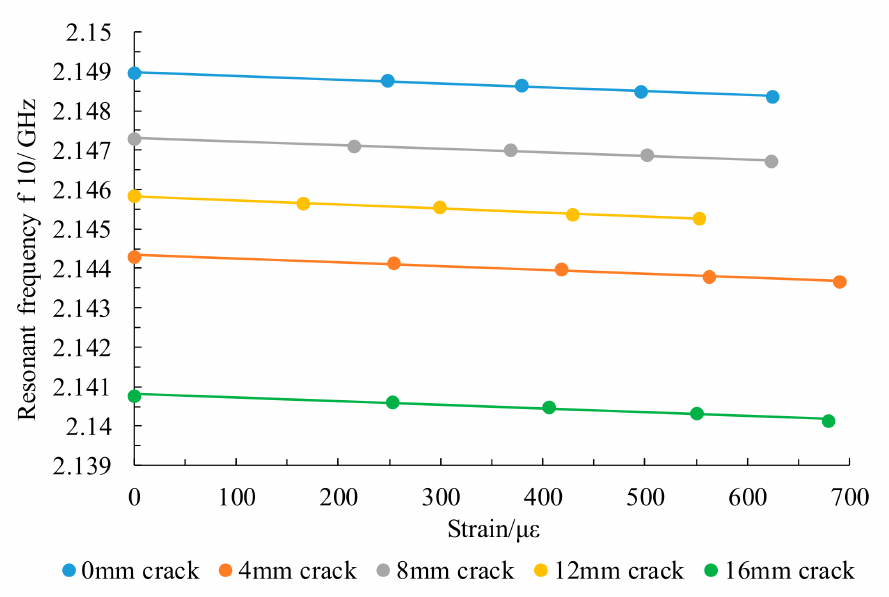
Figure 17. Relationship between resonant frequency and strain in the upper patch during crack